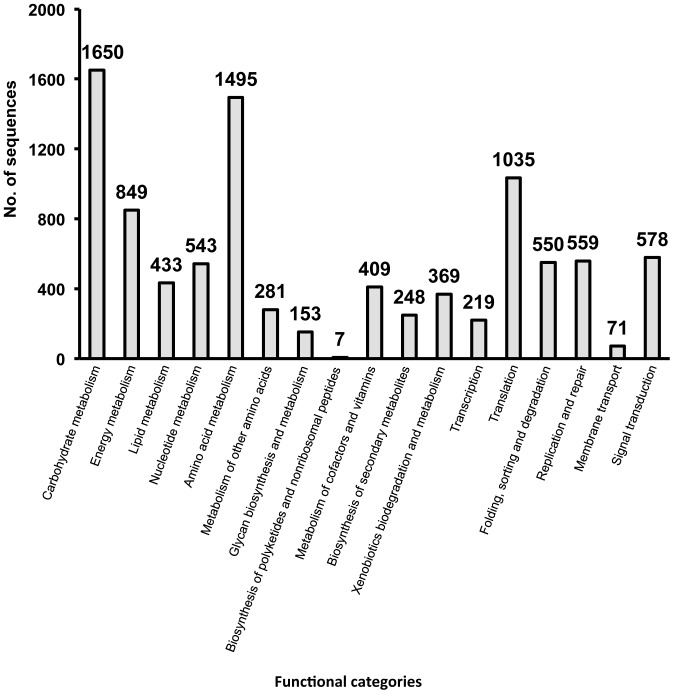
Functional classifications of the putative CDSs derived from the metatranscriptomic approach.The functional genes were determined using a BLASTP search according to the KEGG database (http://www.kegg.com/kegg/) with expected values above 1×10−8. Multifunctional genes were classified in redundant categories. Functional categories: carbohydrate metabolism; energy metabolism; lipid metabolism; nucleotide metabolism; amino acid metabolism; metabolism of other amino acids; glycan biosynthesis and metabolism; biosynthesis of polyketides and nonribosomal peptides; metabolism of cofactors and vitamins; biosynthesis of secondary metabolites; xenobiotics biodegradation and metabolism; transcription; translation; folding, sorting and degradation; replication and repair; membrane transport; and signal transduction.